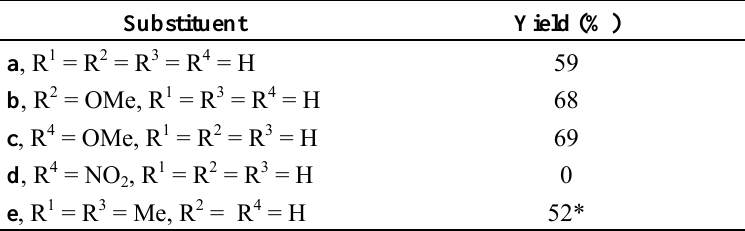
Table 13. The effect of substituents on the yield of photosensitized dehydrogenation of flavanones to flavones with 2,4,6-triphenylpyrylium tetrafluoroborate (TPT) (R 1 – R 4 substituents on 106 and 107